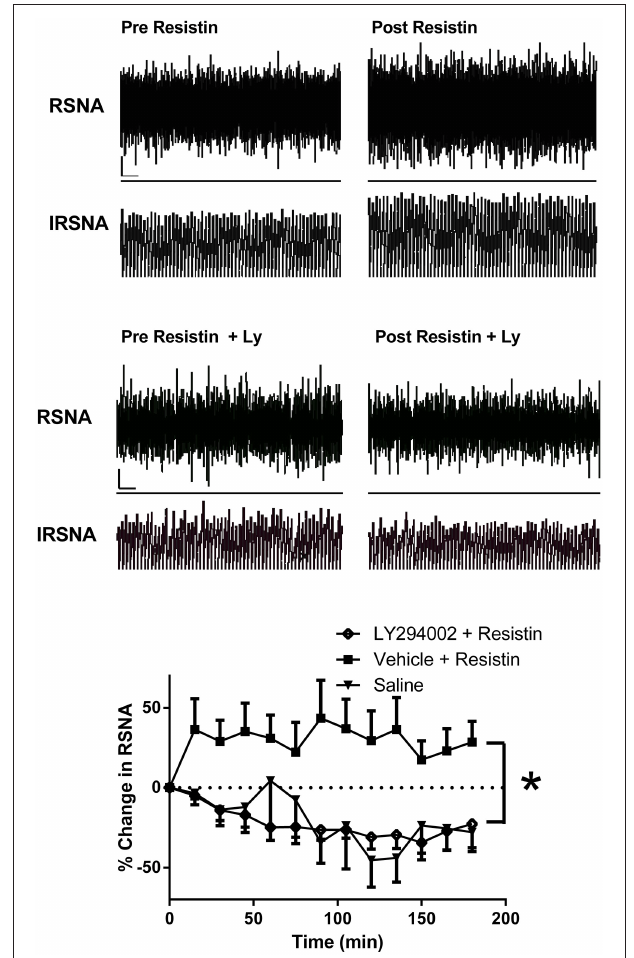
FIGURE 2 | Top: Screen capture of raw recordings of renal sympathetic nerve activity (RSNA) and integrated renal SNA (IRSNA) before and after resistin (7 µ g) administered into the lateral brain ventricle of an anesthetized rat. x , horizontal bar = 2s, vertical bar = 200mV (RSNA), and 10mV.s (IRSNA). Modified from Kosari et al. (2012). Middle: Screen capture of raw recordings of renal sympathetic nerve activity (RSNA) and integrated renal SNA (IRSNA) before and after resistin (7 µ g) in the presence of the PI 3-Kinase inhibitor, LY294002 (Ly) (5 µ g) administered into the lateral brain ventricle of an anesthetized rat. x , horizontal bar = 2s, vertical bar = 200mV (RSNA), and 10mV.s (IRSNA). Modified from Kosari et al. (2012). Lower: The percent changes in renal sympathetic nerve activity (RSNA) from basal levels over time following intracerebroventricular administration of saline (control) ( n = 4 ) or resistin (7 µ g) in the presence of LY294002, an inhibitor of PI3K (5 µ g, n = 5 ) or vehicle ( n = 7 ). * p < 0.05 between groups, Two-way ANOVA. Modified from Kosari et al.